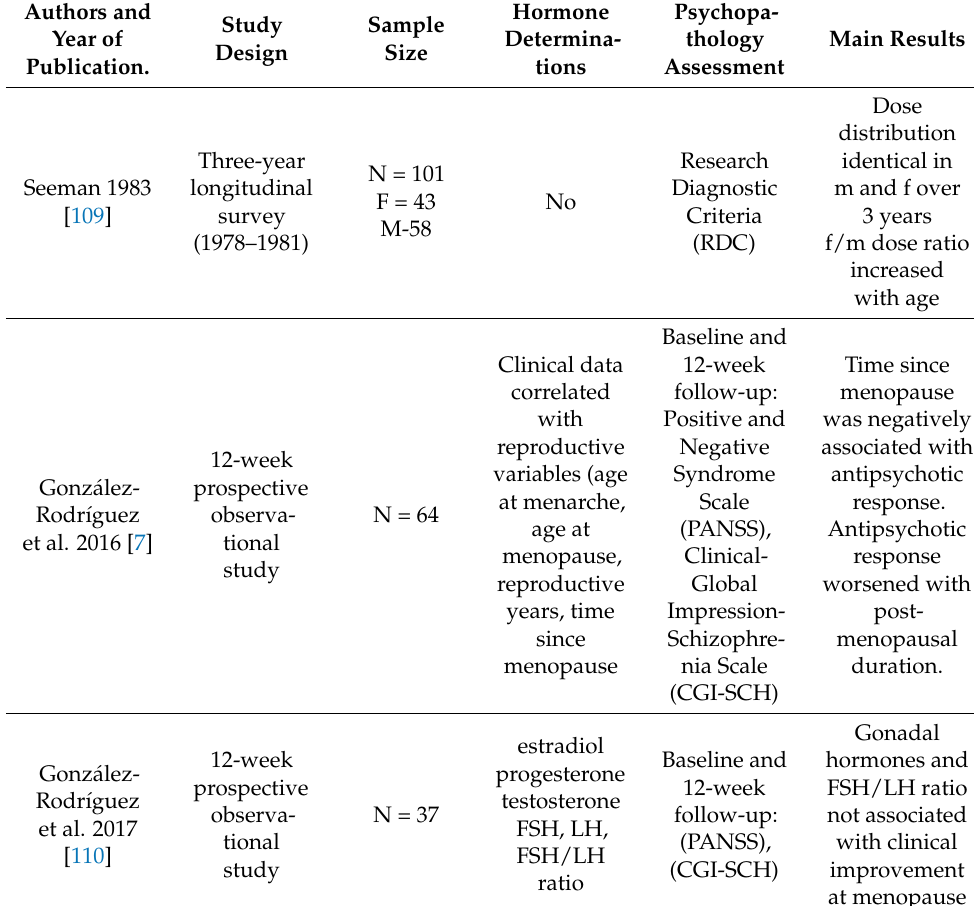
Table 2. Changes in clinical response in postmenopausal women with